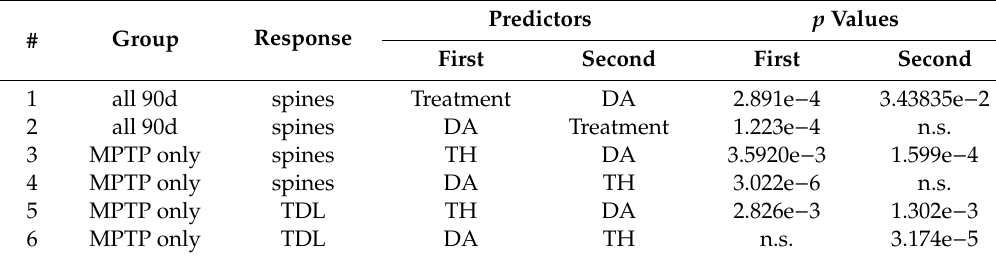
Table 3. Analyses of MSN morphology at 90 days by linear models.